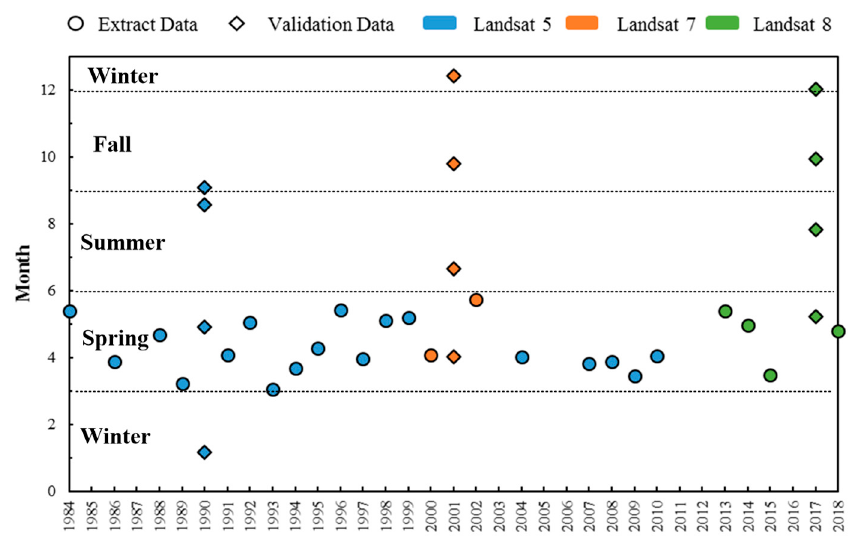
Figure 2. Temporal distribution of Landsat images used in this study.